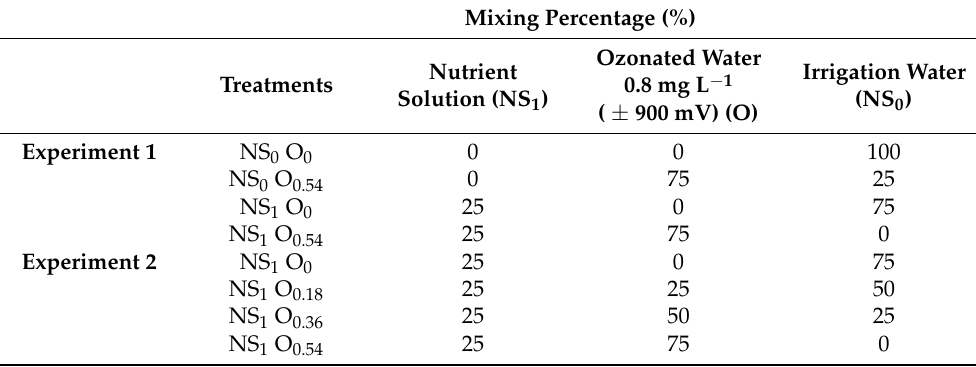
Table 4. Characterization of the mixture (in %) supplied in each treatment: tap irrigation water (NS 0